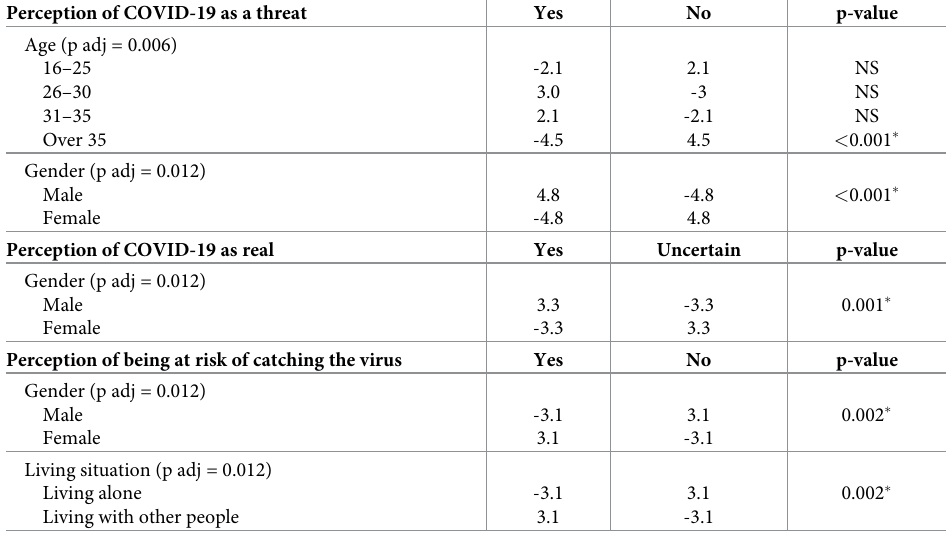
Table 4a. Post-hoc adjusted residuals for risk perceptions with Bonferroni